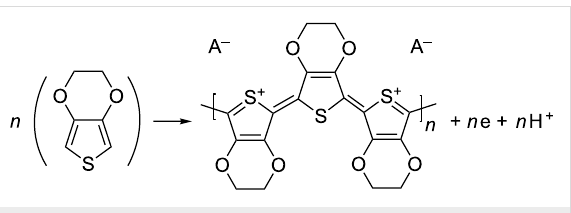
Scheme 1: Polymerization reaction scheme for PEDOT synthesis.